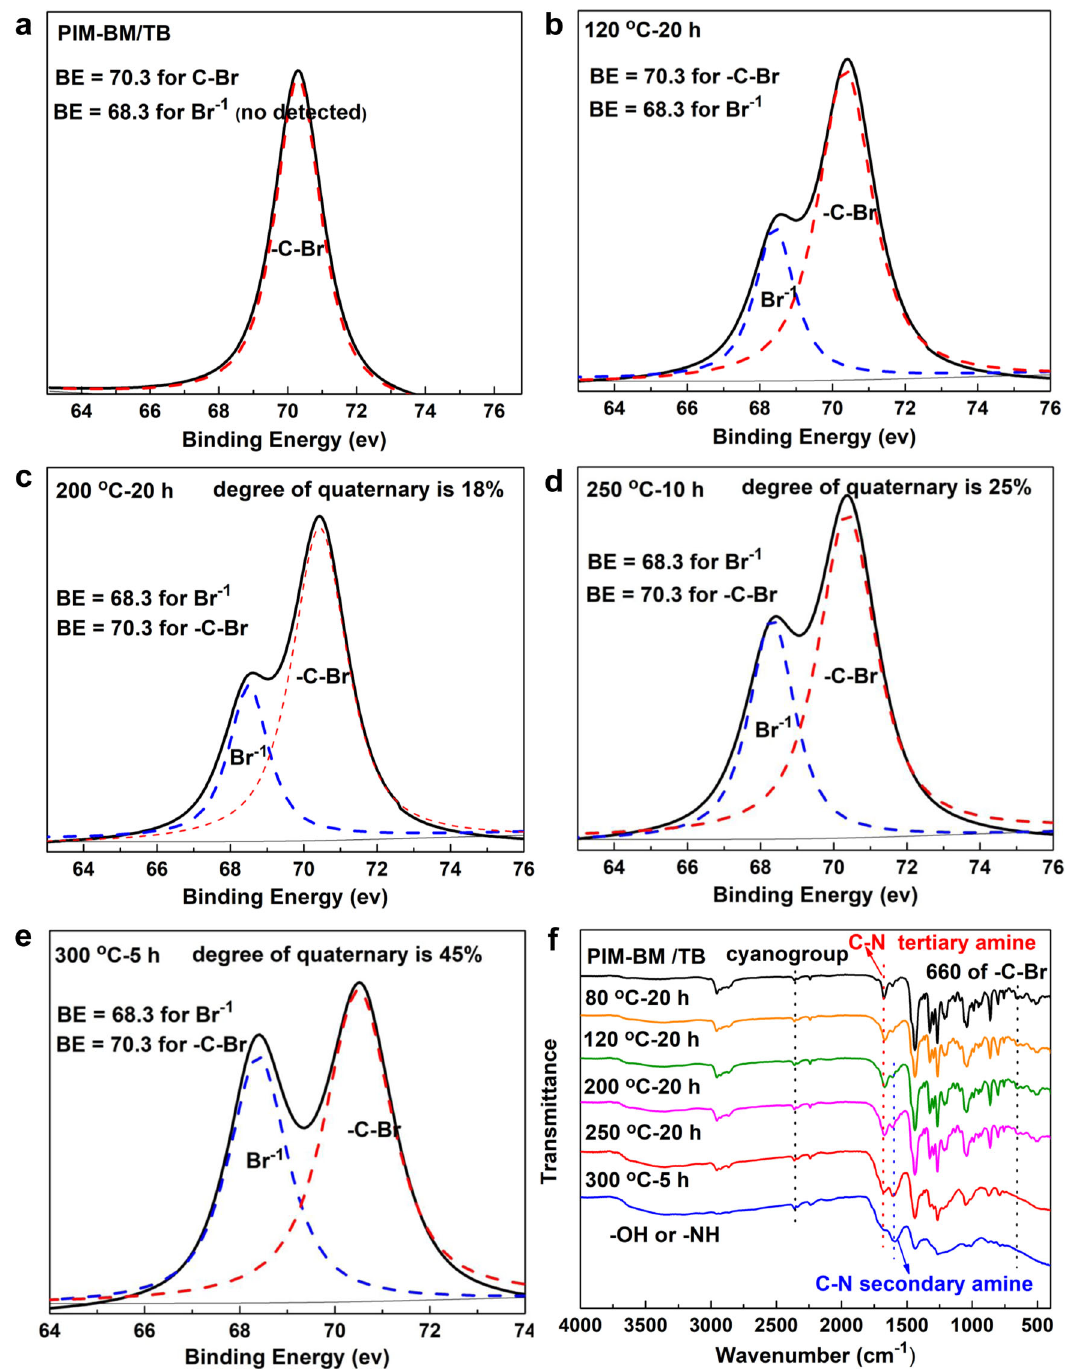
Fig. 3 Structural characterizations of fresh and thermally crosslinked PIM-BM/TB. a XPS spectrum of Br 3 d of fresh PIM-BM/TB. b XPS spectrum of Br 3 d of PIM-BM/TB-120 °C-20 h. c XPS spectrum of Br 3 d of PIM-BM/TB-200 °C-20 h. d XPS spectrum of Br 3 d of PIM-BM/TB-250 °C-10 h. e